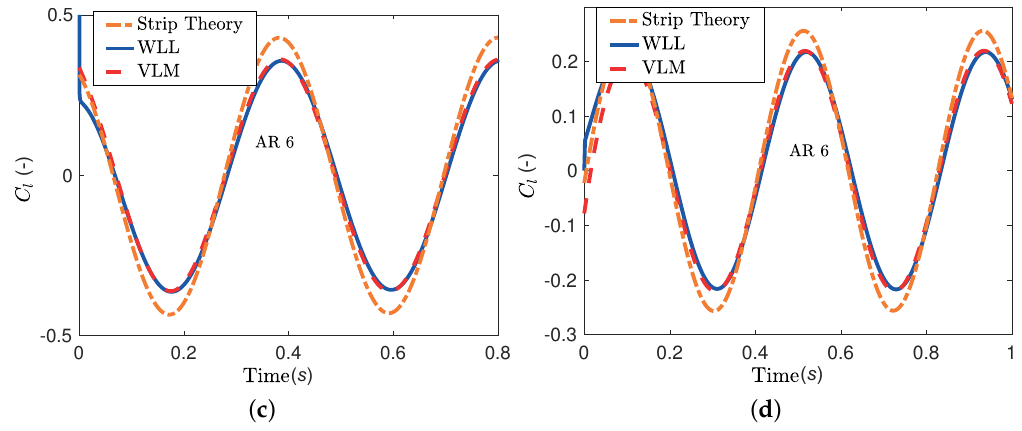
Figure 8. Lift comparison between VLM, WLL and strip theory for a rectangular wing undergoing an oscillation motion. ( a ) Oscillation in pitch with A = 5 ◦ and k = 0.1; ( b ) Oscillation in plunge with A = 0.1 m and k = 0.1; ( c ) Oscillation in pitch with A = 5 ◦ and k = 0.3; ( d ) Oscillation in plunge with A = 0.1 m and k = 0.3.